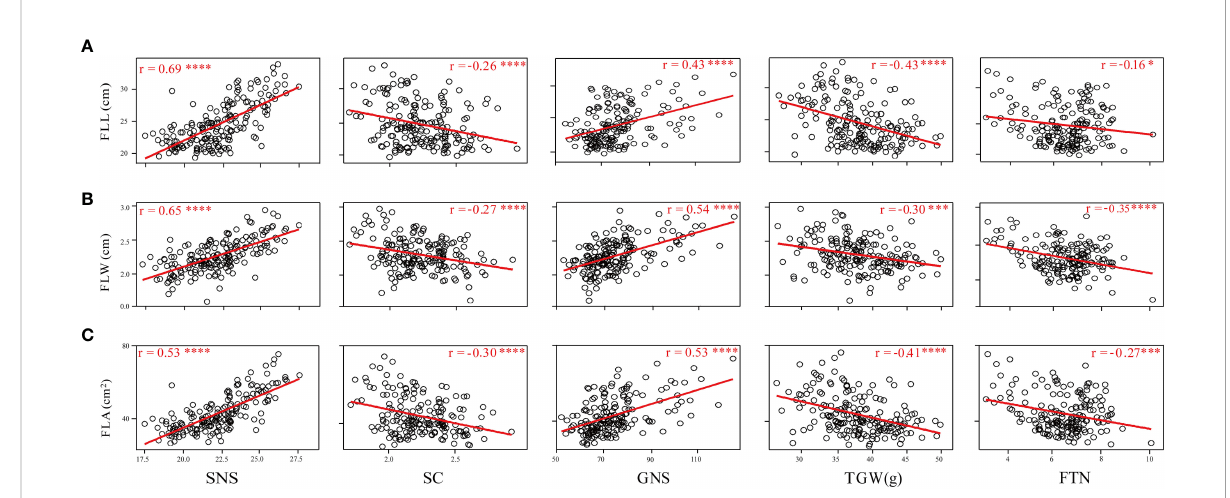
FIGURE 3 Coef fi cients of pairwise Pearson ’ s correlations between fl ag leaf length (A) , fl ag leaf width (B) , and fl ag leaf area (C) and yield-related traits in the WC12 population. *, *** and **** represent signi fi cant at P < 0.05, P < 0.005 and P < 0.001,